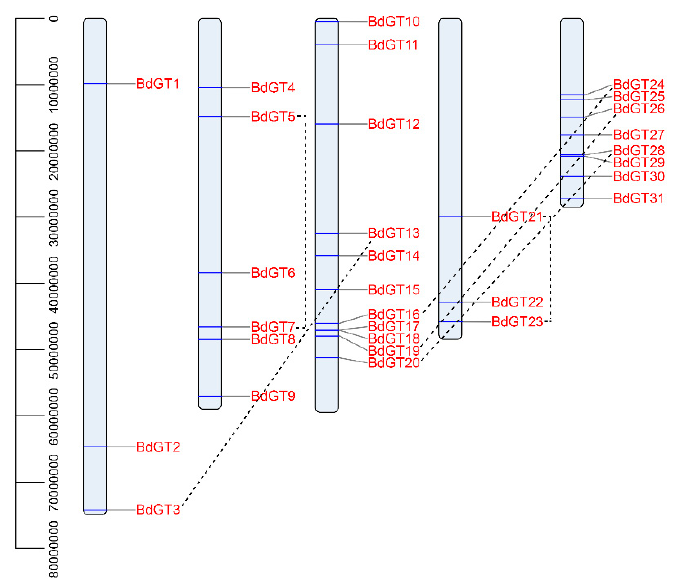
Figure 1. Chromosome distribution of GT genes in B. distachyon . The chromosome numbers are indicated at the top of each chromosome image. Gene duplication analysis of BdGTs was also presented with a dash line.